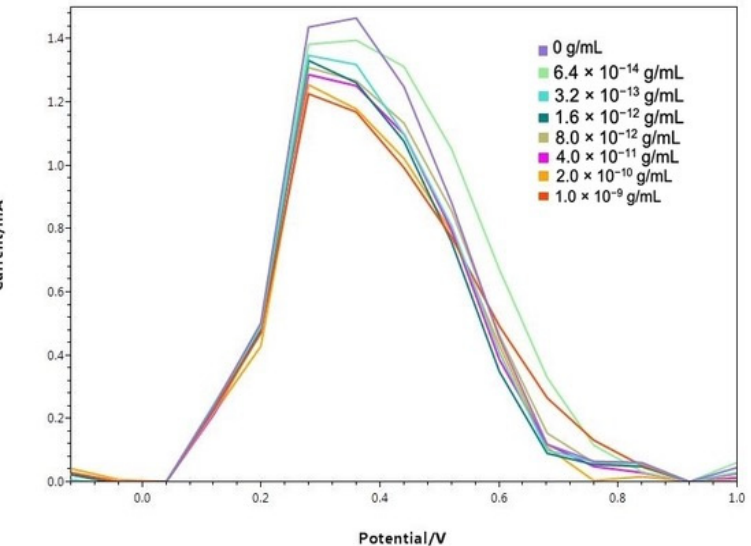
Figure 6. Baseline corrected square wave voltammetries of modified electrodes incubated for 10 min at different NP concentrations.